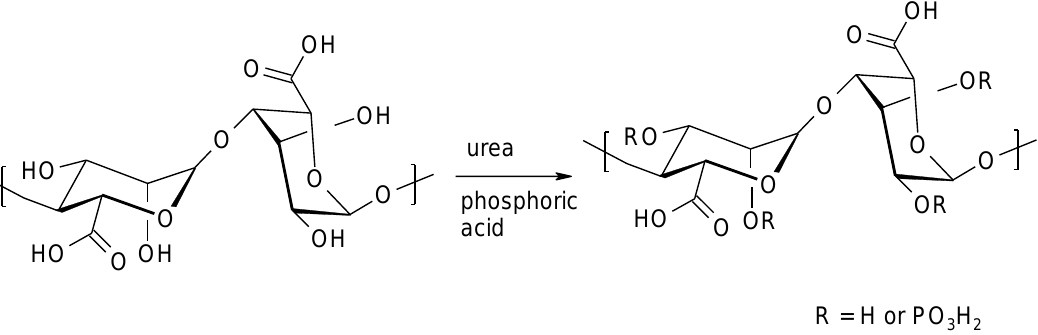
Figure 7. Phosphorylation of alginates.